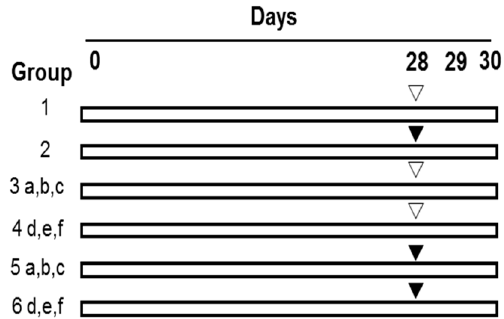
Figure 3. Experimental design to analyze the effect of Se-PFPs on micronuclei formation induced